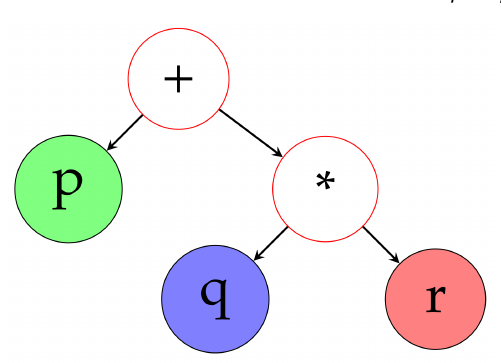
Figure 7. The expression tree of Equation